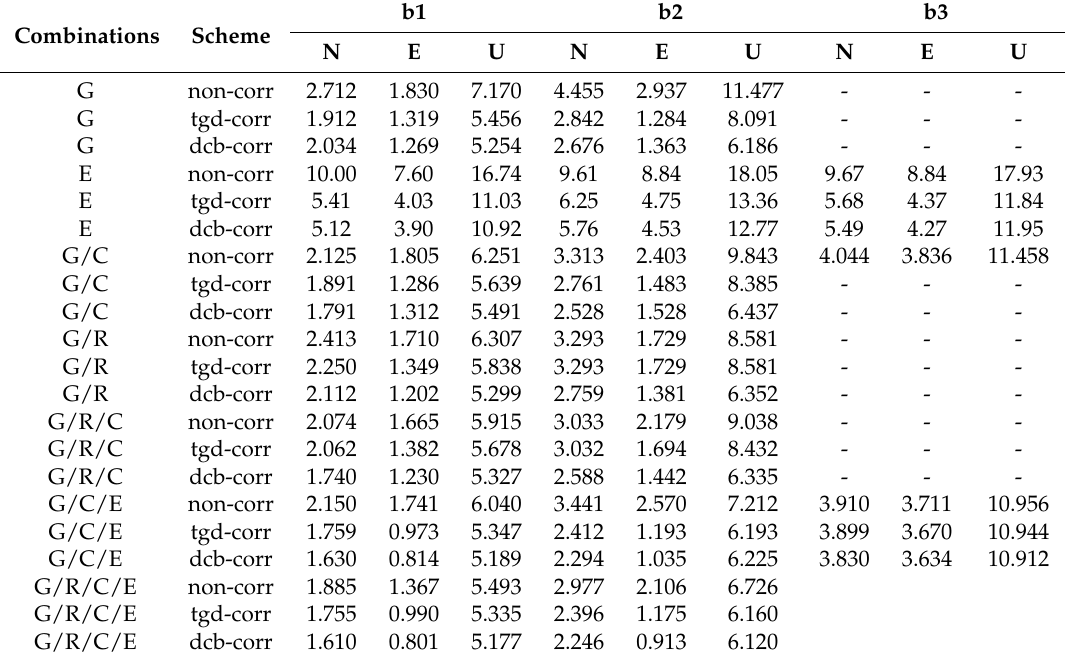
Table 3. RMS of single-frequency standard point positioning (unit: